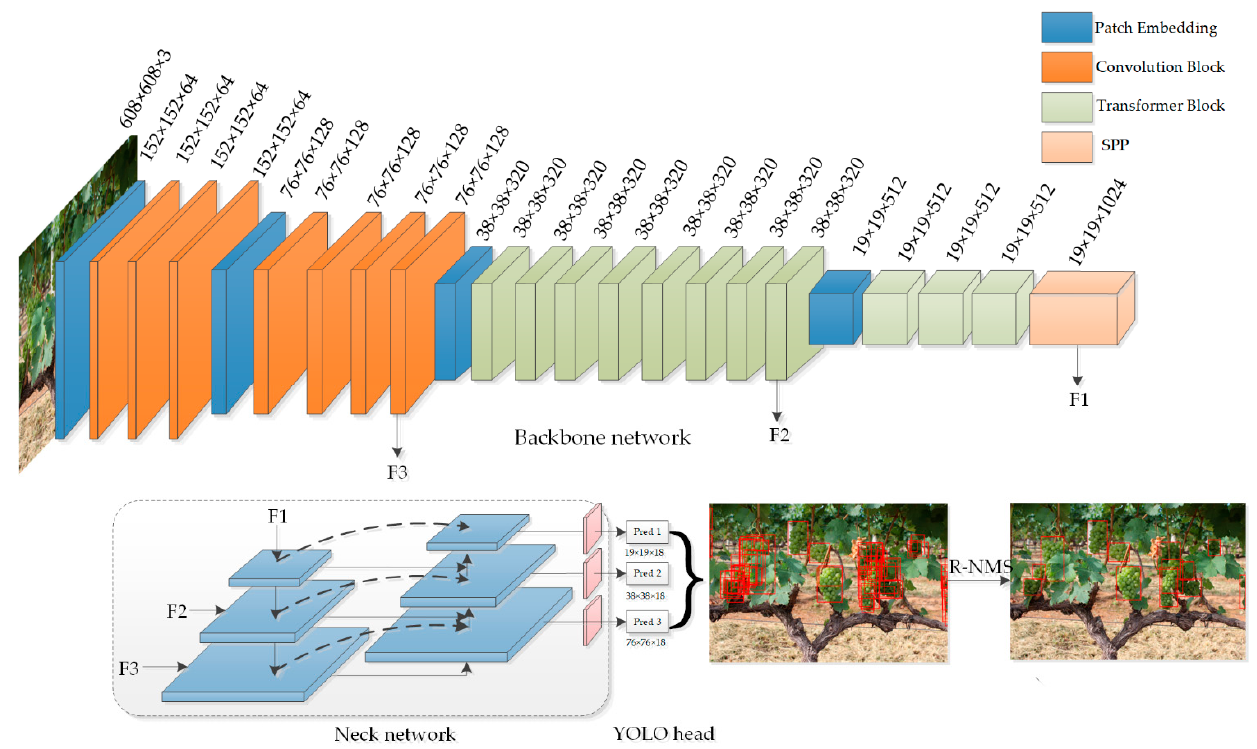
Figure 3. The network structure of our